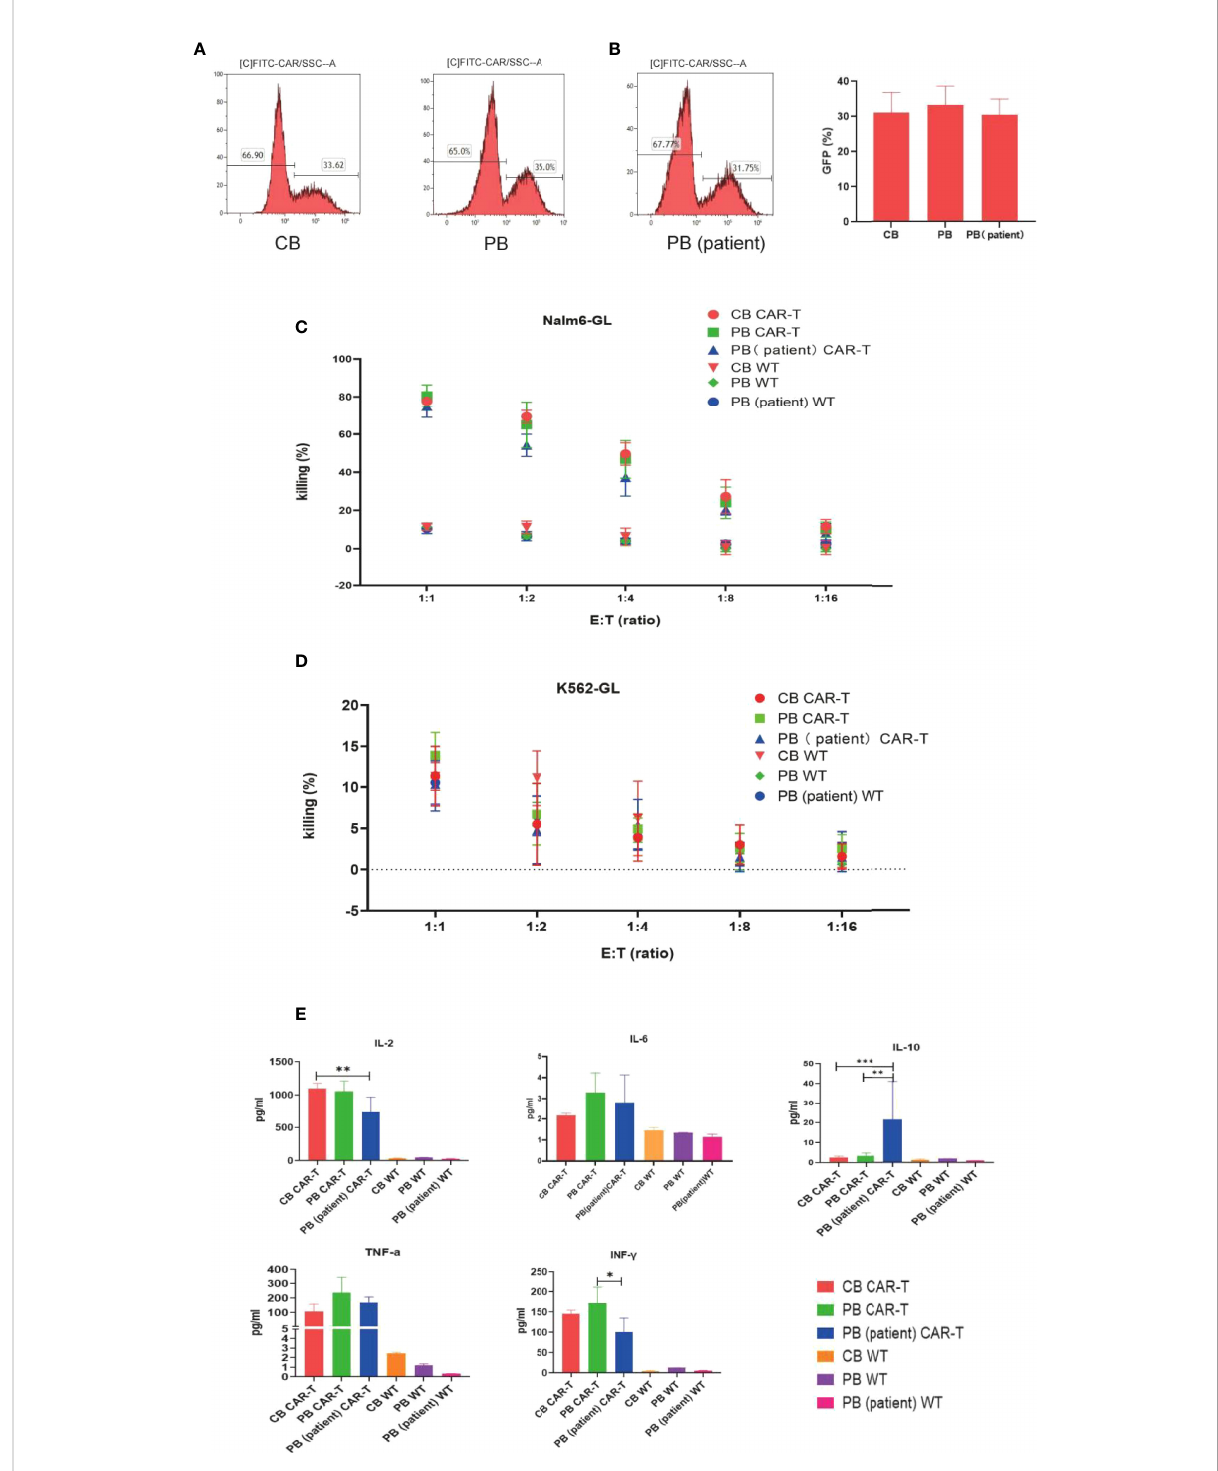
FIGURE 2 Transfection ef fi ciency and function of CAR-T cells in the three groups. (A) CAR expression of T cells in the three groups measured by fl ow cytometry. (B) Transfection ef fi ciency among the three groups. (C) Killing ef fi cacy of Nalm6-GL by CB CAR-T, PB CAR-T, PB (patient) CAR-T, and control wild-type T cells after coculture for 18 h Results are representative of at least three independent experiments with T cells from different healthy donors. (D) Killing ef fi cacy of K562-GL by CB CAR-T, PB CAR-T, PB (patient) CAR-T, and control wild-type T cells after coculture for 18 h. Results are representative of at least three independent experiments with T cells from different healthy donors. (E) Levels of IL-2, IL-6, IL-10, TNF- a , and IFN- g in the supernatant after the CAR-T cells were cocultured with Nalm6-GL. *p < 0.05, **p < 0.01, ***p <